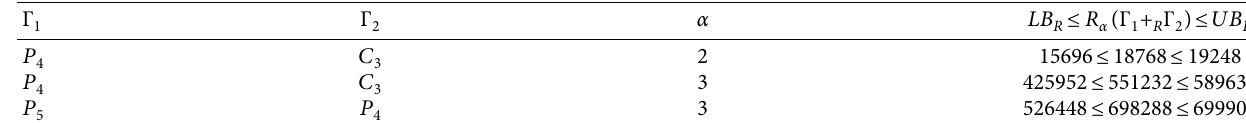
Table 4: Edge partition based upon degree of end vertices of graph P